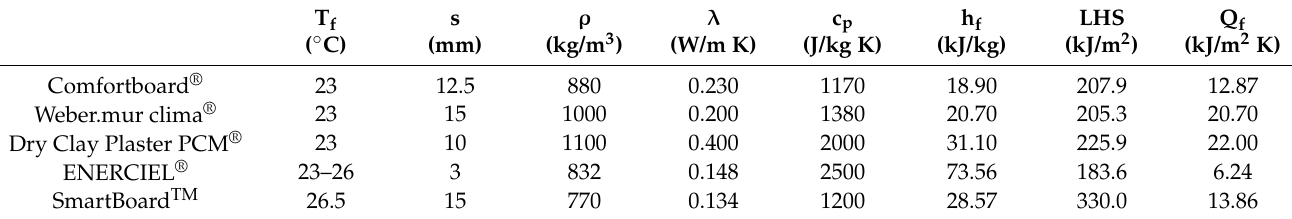
Table 2. Properties of building materials with microencapsulated PCM.